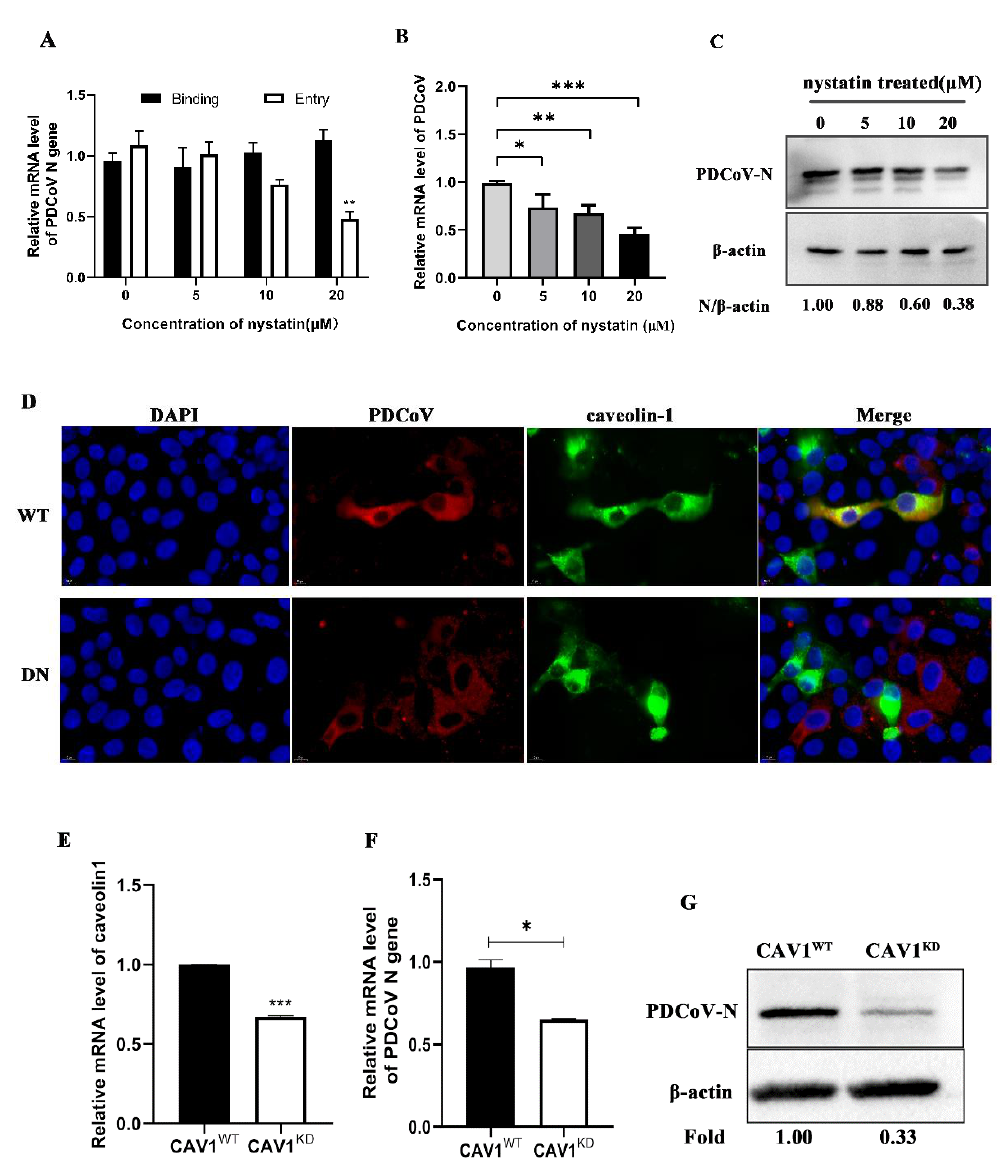
Figure 2. PDCoV entry into porcine kidney (PK-15) cells depends on the caveolae-mediated endocytosis pathway. ( A ). PK-15 cells were pretreated with nystatin at 37 ◦ C for 1 h and infected with PDCoV (MOI of 5) at 4 ◦ C for 1 h (binding step), and then shifted to 37 ◦ C for 1 h (entry step). Cells were lysed to determine viral mRNA level by qRT-PCR ( B , C ). Cells were mock-treated or treated with nystatin for 1 h followed by infection with PDCoV (MOI = 0.1). At 24 hpi, mRNA expression levels of total PDCoV were detected by real-time quantitative PCR ( B ) and protein expression levels of intracellular PDCoV were detected by Western blotting ( C ). ( D ) PK-15 cells were transfected with caveolin-1 wild type (WT) or caveolin-1 dominant-negative (DN), followed by infection with PDCoV 24 h later (MOI = 0.1). At 24 hpi, the cells were fixed and immunostained. Scale bar, 10 µ m. ( E – G ) Caveolin-1 knockdown and normal cells were infected with PDCoV (MOI = 0.1). The knockdown efficiency was verified by qRT-PCR ( E ). At 24 hpi, the viral RNA and N protein levels were determined by qRT-PCR ( F ) and Western blotting ( G ), respectively. * p < 0.05, ** p < 0.01, *** p <